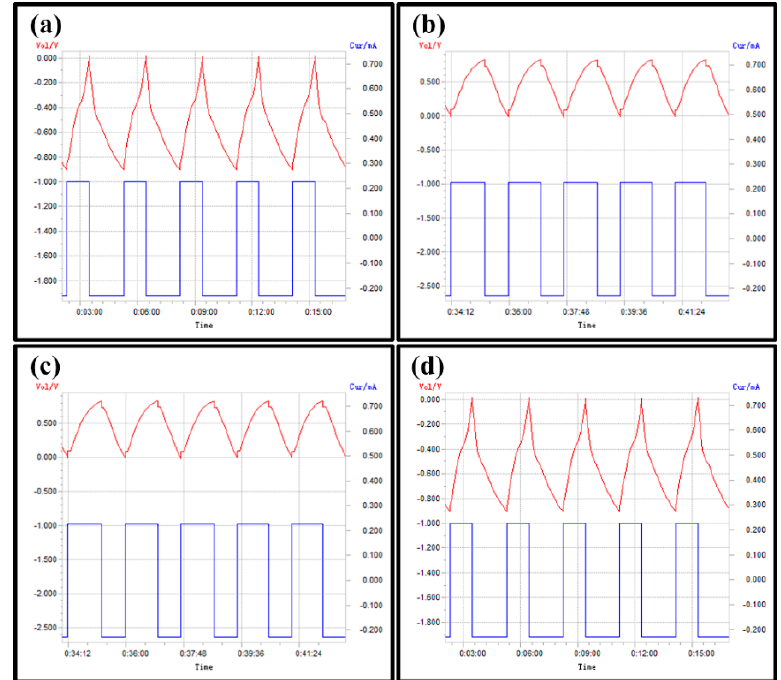
Figure 10. Voltage/time cycling plot of ( a ) GO, ( b ) GO/AgDBSA–PANI ( c ) GO/Cu/DBSA–PANI, ( d ) GO/Pt/DBSA–PANI; voltage range (0 to − 0.9 V vs. Ag/AgCl) at 50 A · g − 1 in 1 M KOH ( aq ). Specific charge/discharge current density = 56.8 A · g − 1 .